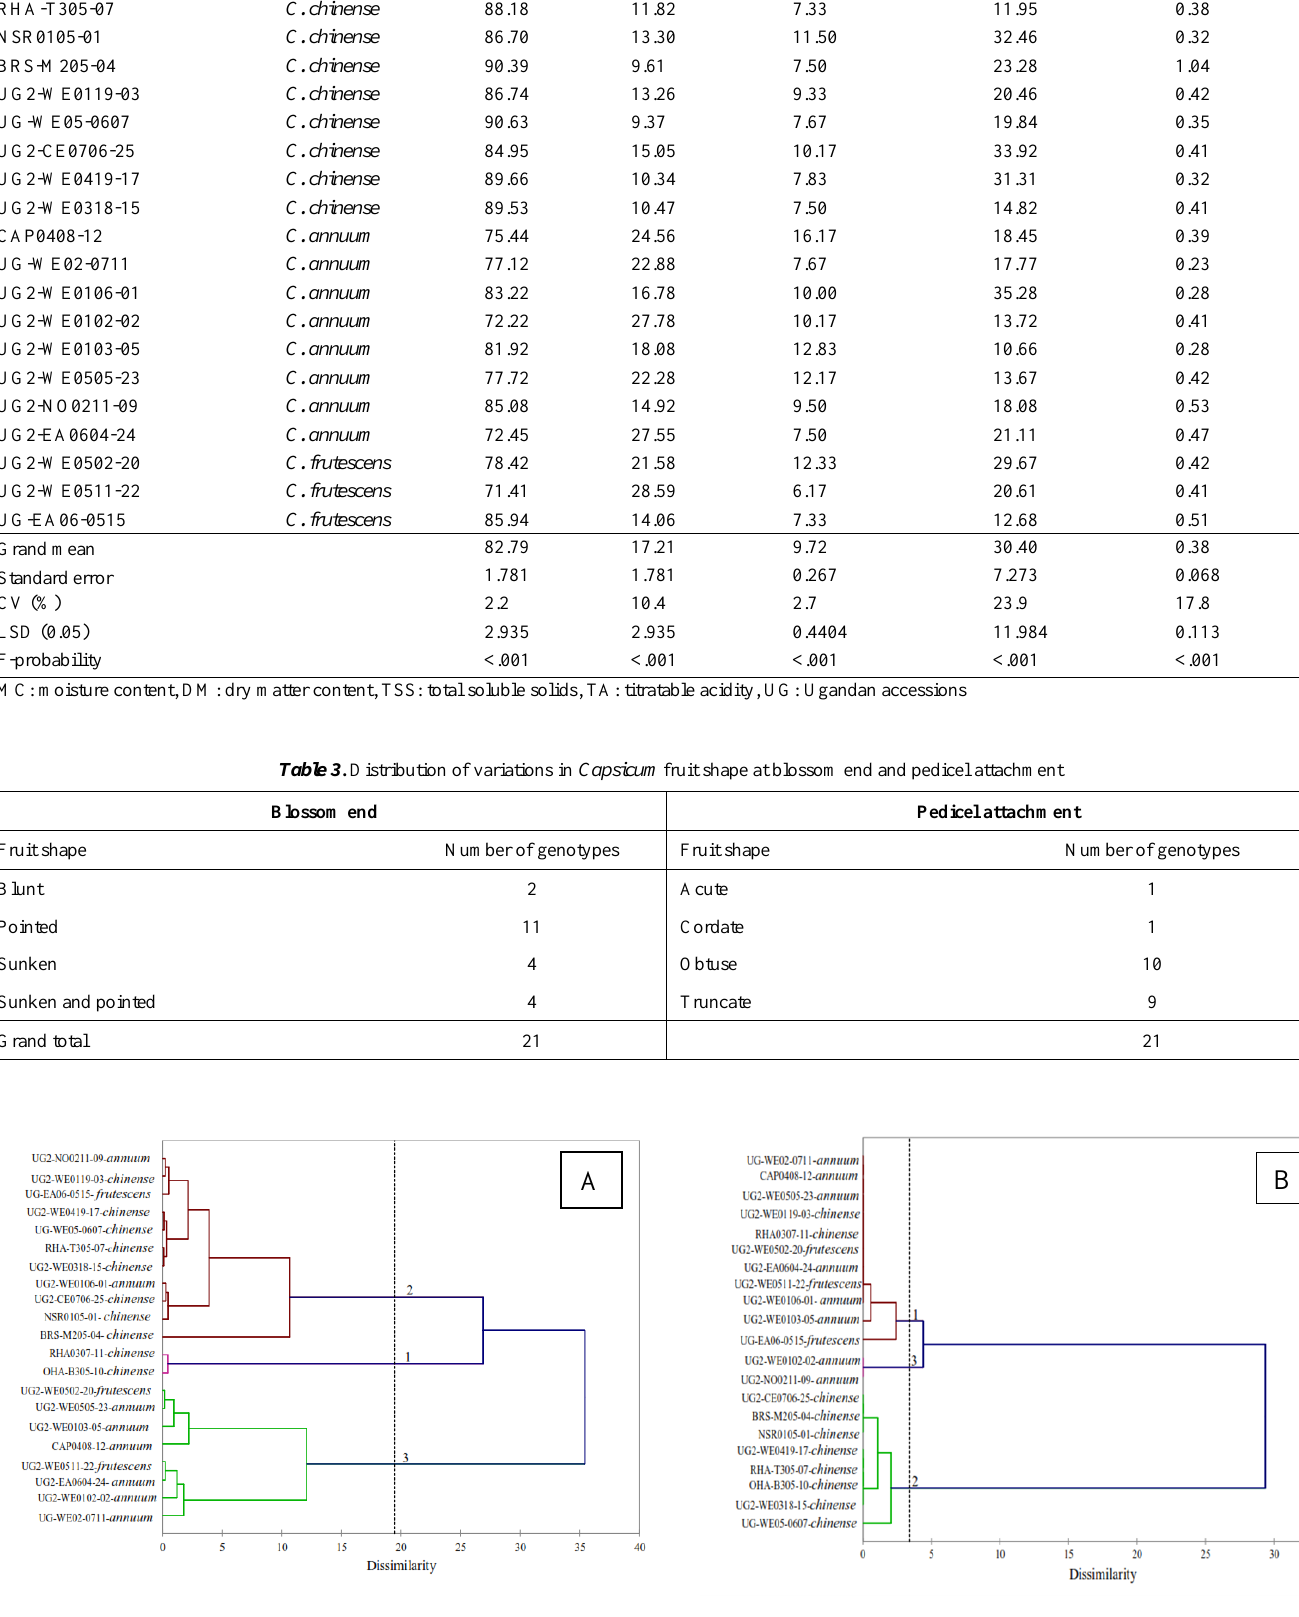
Figure 1. Dendrogram of 21 Capsicum genotypes generated by hierarchical cluster analysis A: Quantitative traits, B: Fruit